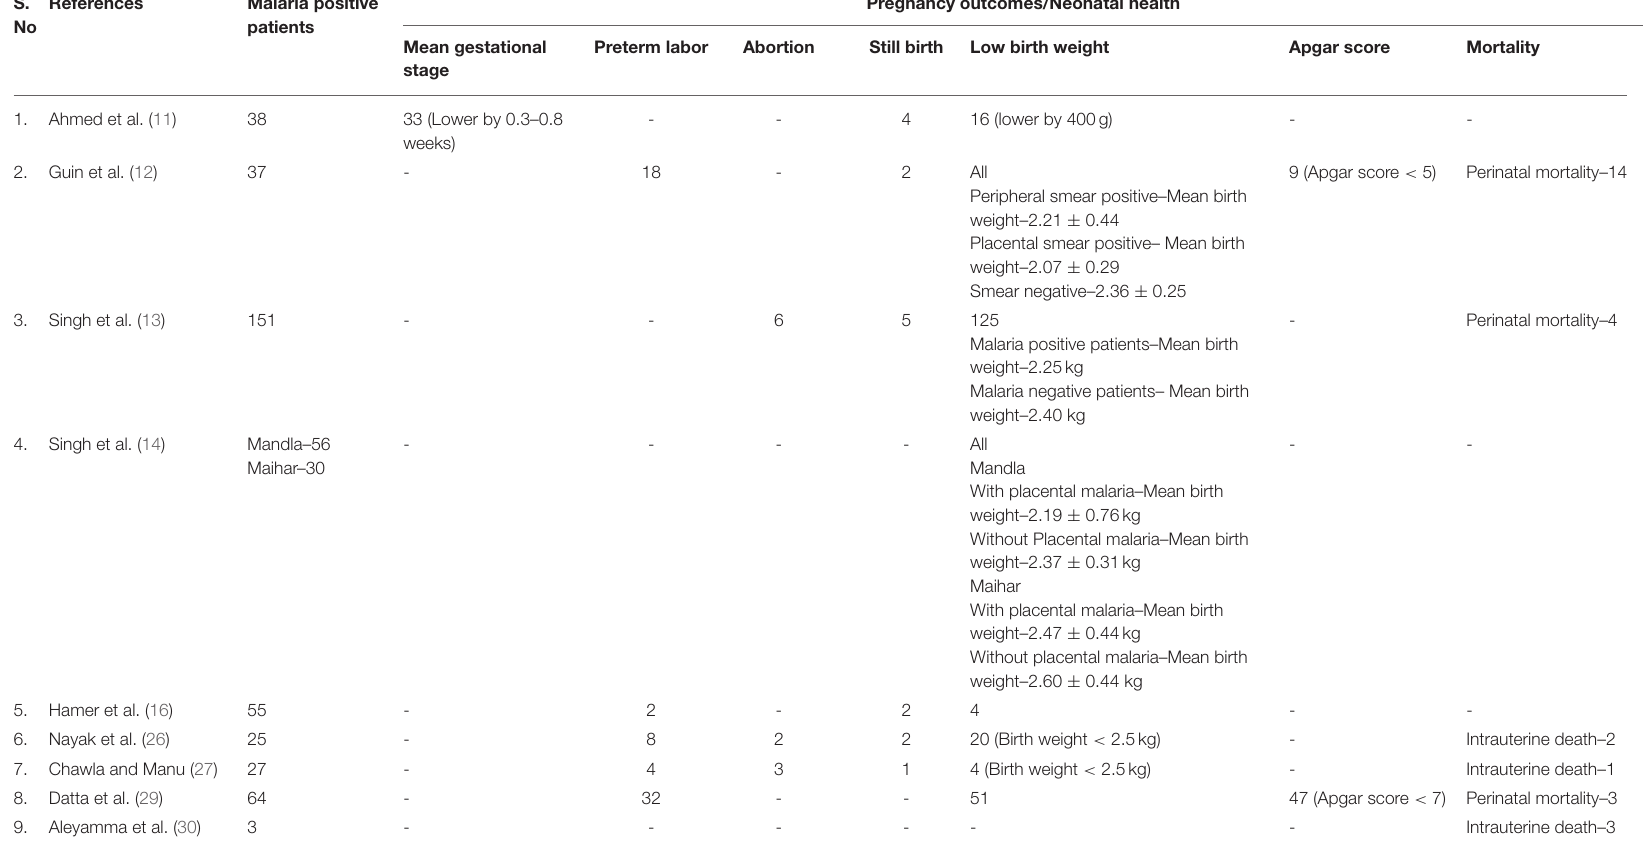
TABLE 4 | Effect of malaria on pregnancy